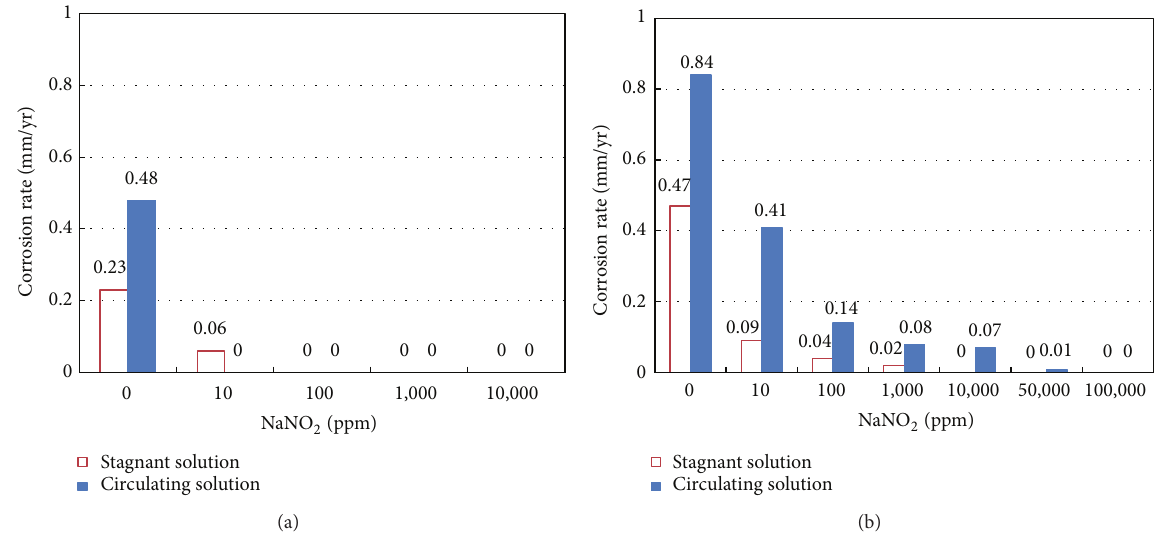
Figure 1: Effect of NaNO 2 addition on corrosion rate in circulating and stagnant simulated cooling water at 25 ∘ C; (a) carbon steel and (b) ductile cast